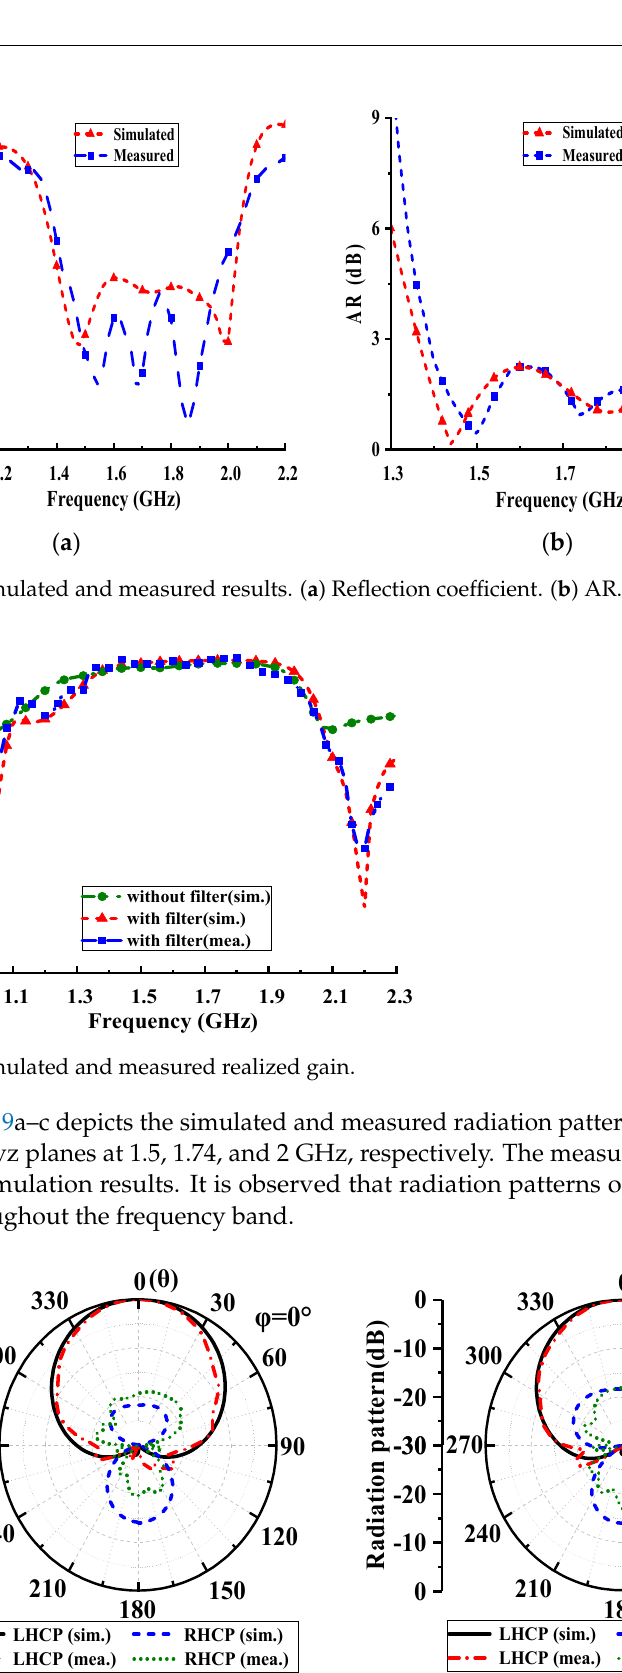
Figure 6. The proposed antenna. ( a ) Fabricated prototype. ( b ) Measured environment.